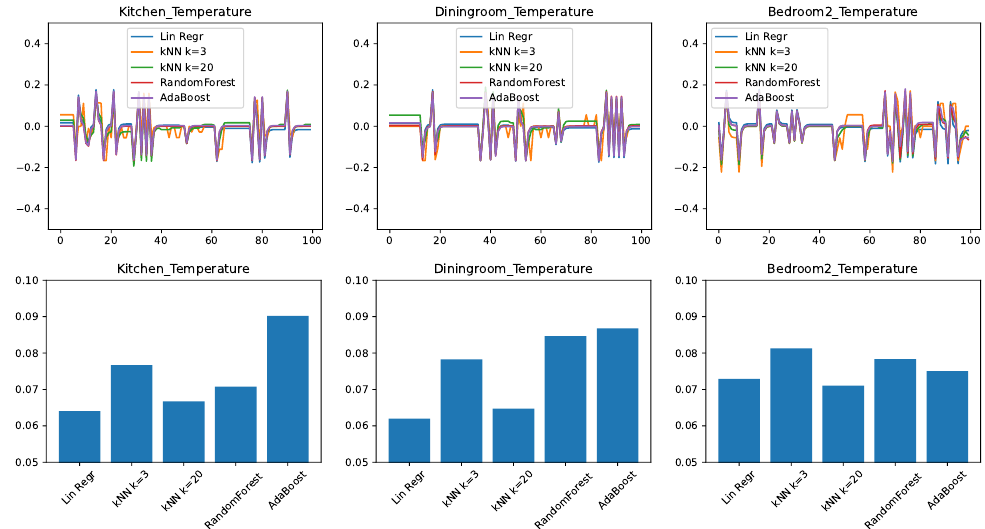
Figure 2. Comparing different regressors for temperature change prediction with a minimal feature set. ( top ) Prediction error in time. ( bottom ) RMSE over the test